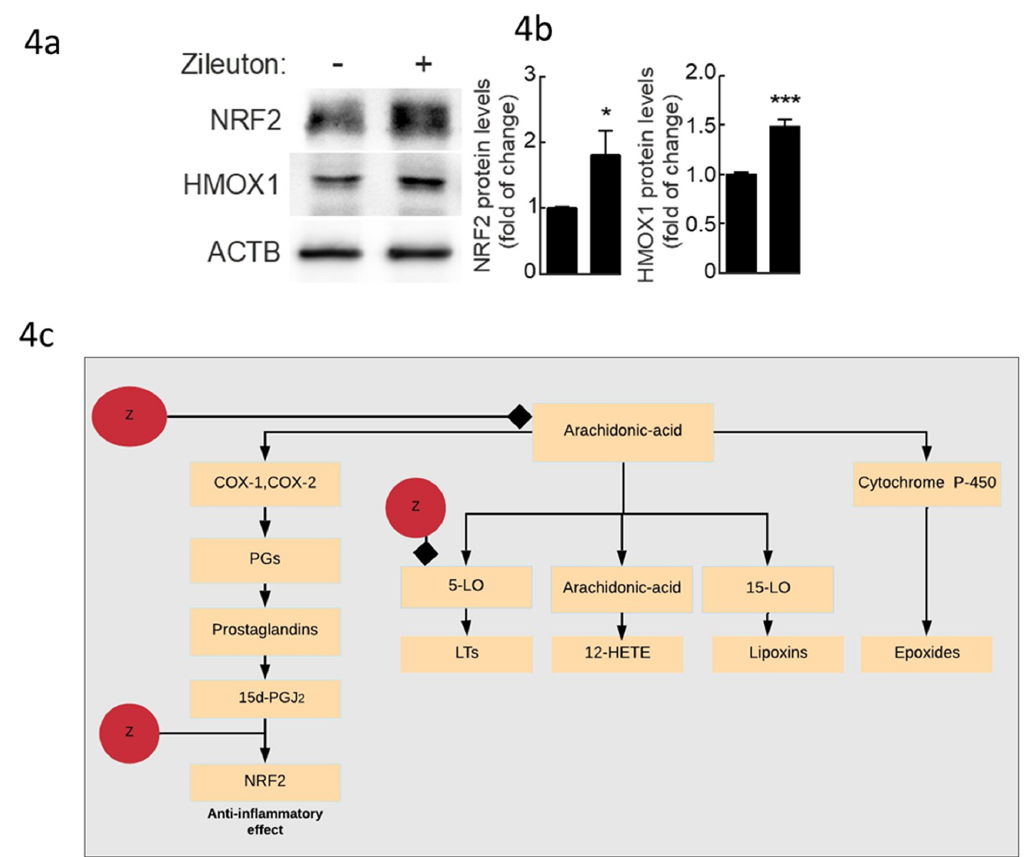
Figure 4. Zileuton activates Nrf2. A, Representative immunoblots for the indicated proteins in cell lysates from RAW264.7 cells treated with zileuton (10 μ M, 16 h) in the absence of serum. ( 4b ) Densitometric quantification of representative immunoblots from ( 4a ) relative to ACTB protein levels. Data are mean ± SEM ( n = 4). Statistical analysis was performed using Student’s t test. * p < 0.05; **** p < 0.001 vs. vehicle ‐ treated cells. ( 4c ) Zileuton model of action. In response to reactive oxygen species (ROS) stress, AA is released from membrane phopholipids by phospholipases. Free AA can be converted to bioactive eicosanoids through the cyclooxygenase (COX), lipoxygenase (LOX), or P ‐ 450 epoxygenase pathways. LOX enzymes (5 ‐ LO, 12 ‐ LO, and 15 ‐ LO) catalyze the formation of LTs, 12(S)hydroperoxyeicosatetraenoic acids and lipoxins (LXs), respectively. COX isozymes (constitutive